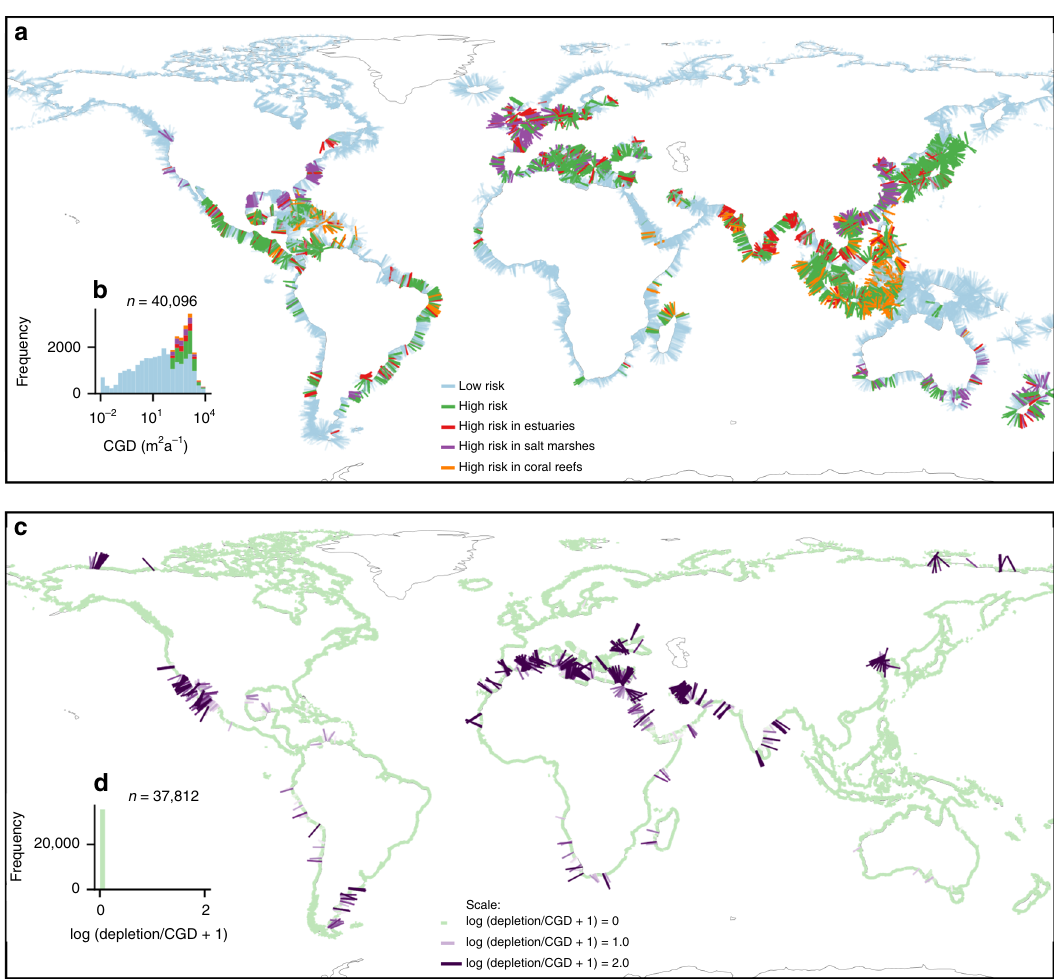
Fig. 4 Maps of the eutrophication risk by coastal groundwater discharge and a comparison between coastal groundwater discharge and groundwater depletion. Coastal groundwater discharge (CGD) can locally pose a eutrophication and pollution risk to coastal ecosystems ( a ). Although the majority of coastal watersheds groundwater depletion is lower than CGD, groundwater depletion locally exceeds CGD in approximately 13% of the global coastline ( b ). The coastal groundwater discharge, eutrophication risk, and groundwater depletion data that are shown here are available as Supplementary Data